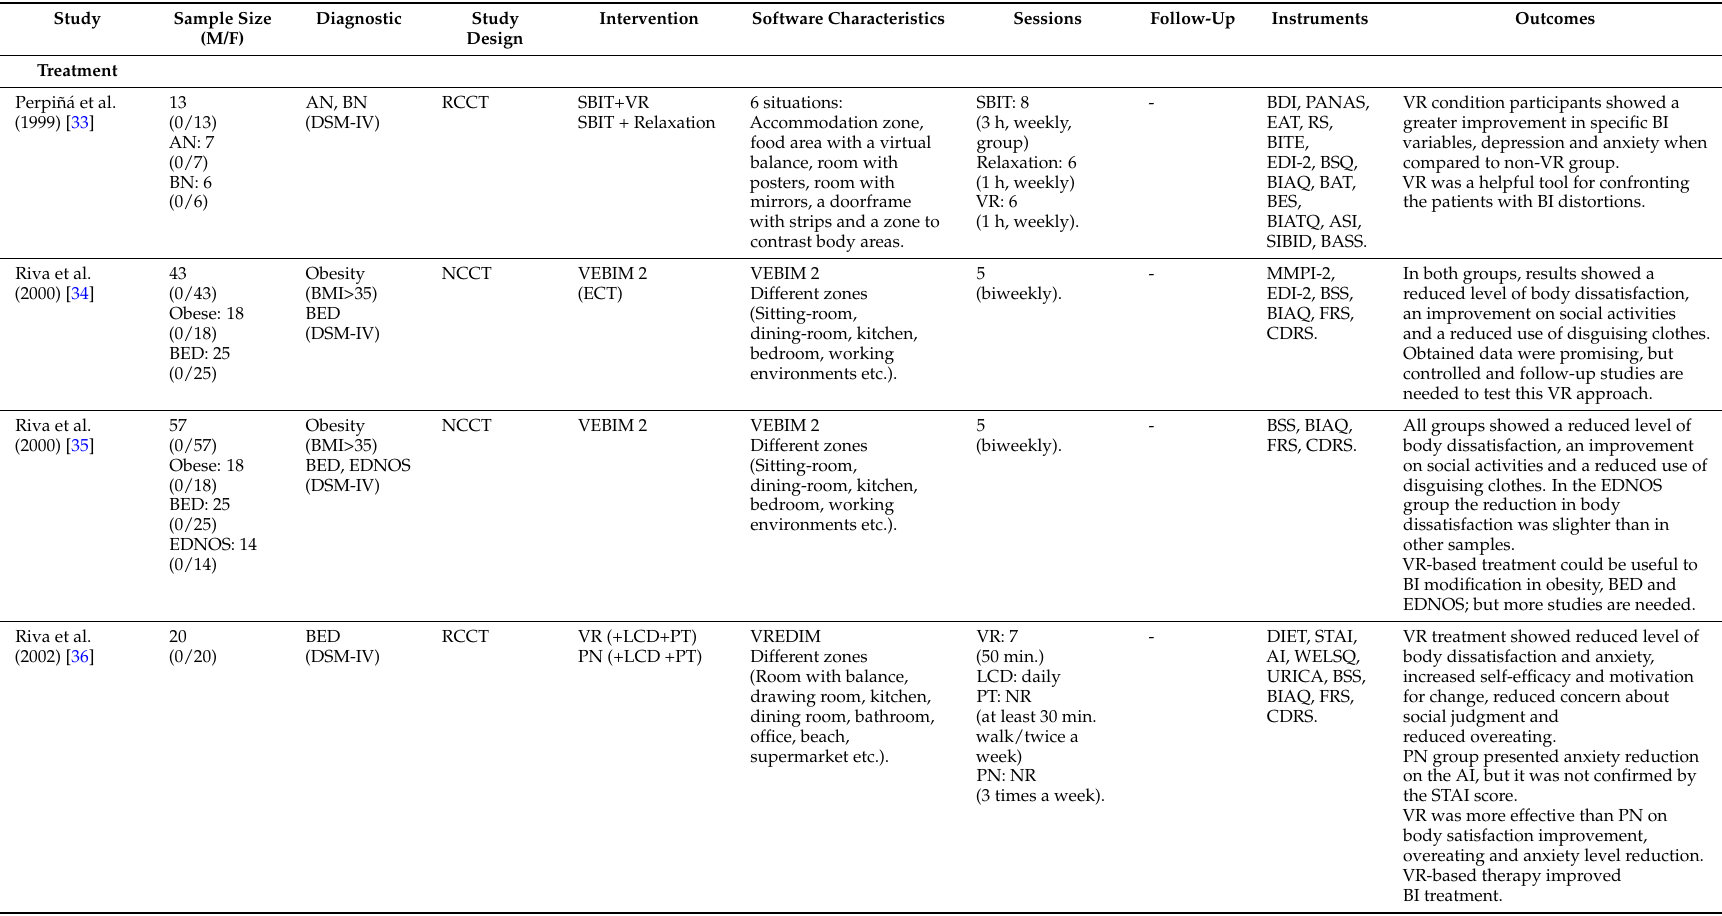
Table 2. Studies using virtual reality in the treatment of bulimia nervosa and binge eating